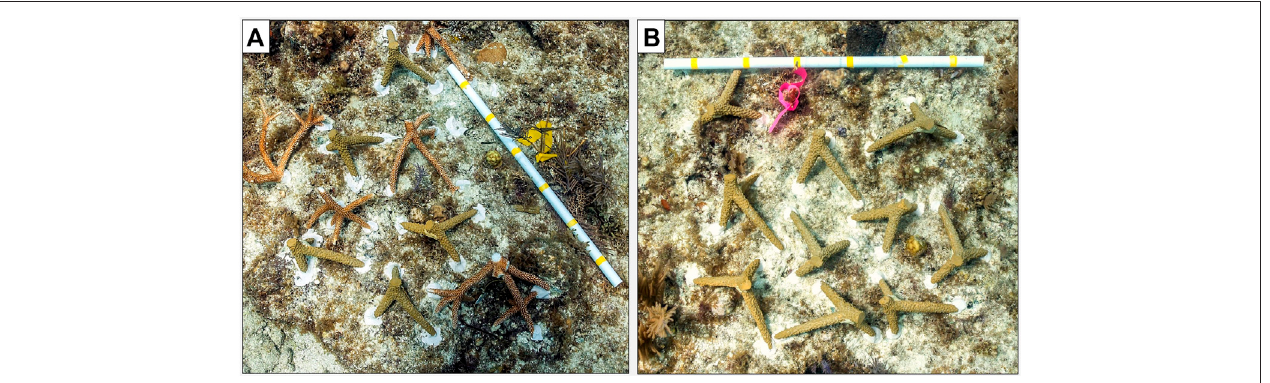
FIGURE4|(A) Example coralreefhabitatpatchcomprised of5arti fi cialcoralhabitat modulescreated via 3D-SPMC,and 5livingcorals(i.e.,50%livingcoralinthe patch=50%livingcoraltreatment)deployedinareplicated insitu experimentinFL,UnitedStatestotesttheeffectoflivecoralcontent(i.e.,%)withinreefhabitatpatches, while controlling for structural habitat complexity, on reef fi sh recruitment in areas of high or low seascape structural complexity. (B) Example coral reef habitat patch comprised of 10 arti fi cial coral habitat modules created via 3D-SPMC, and 0 living corals (i.e., 0% living coral in the patch = 0% living coral treatment).